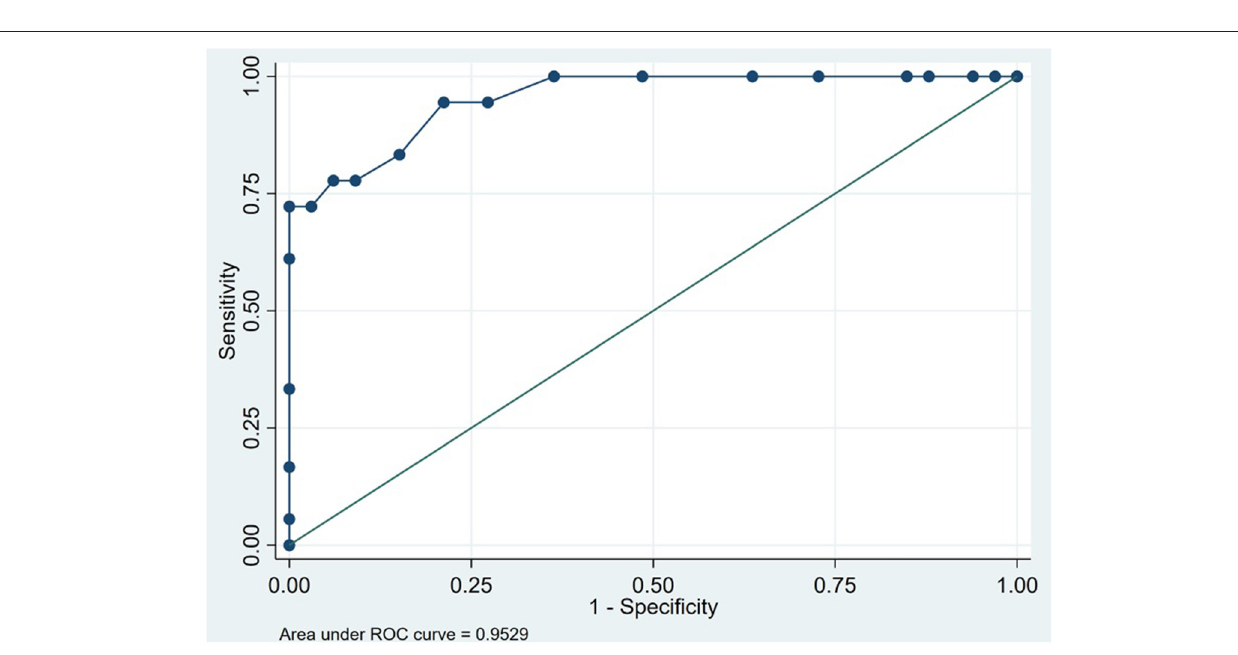
battery. Other recommendations include using validated